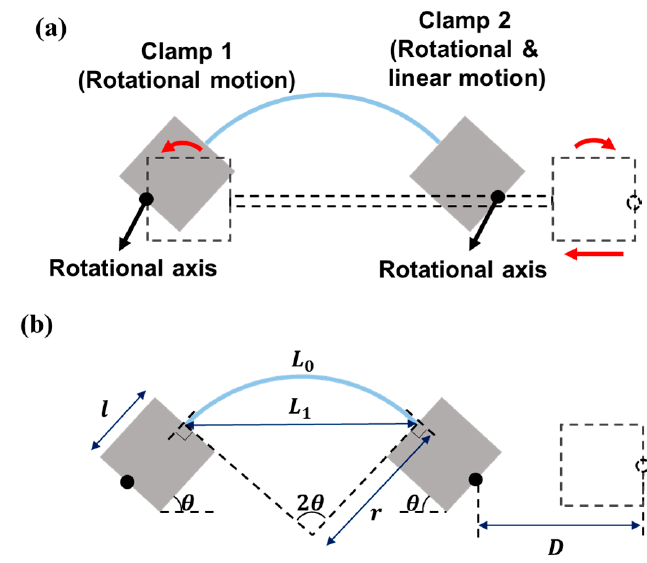
Figure 6. ( a ) Schematic of the deformed specimen in an arc shape; ( b ) related variables and geometric properties.